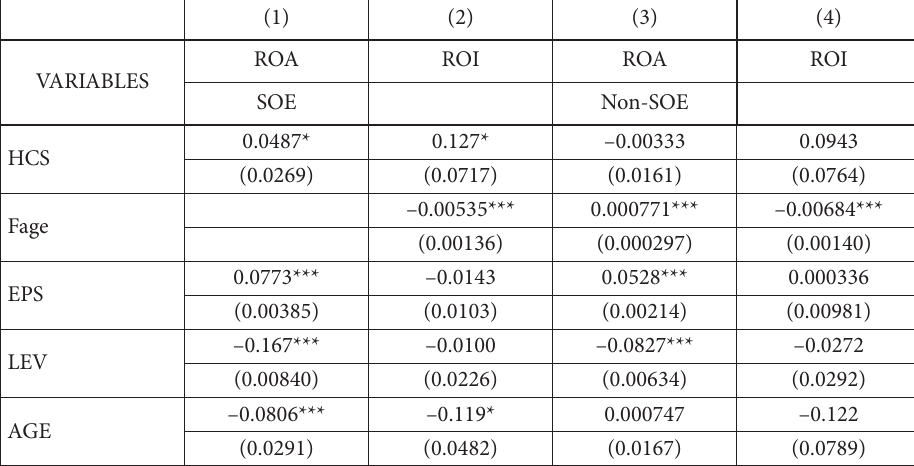
Table 2. 2sls instrumental regression (hierarchical jumps and SOEs, Non-SOEs